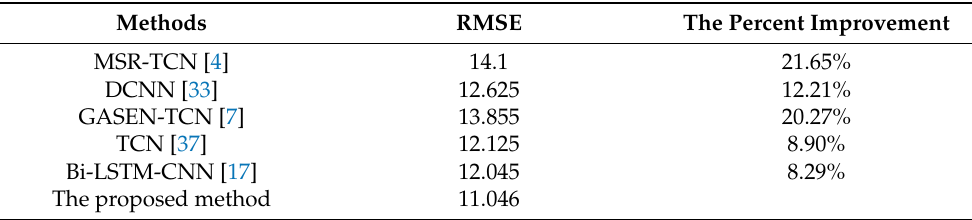
Table 11. Comparison of different